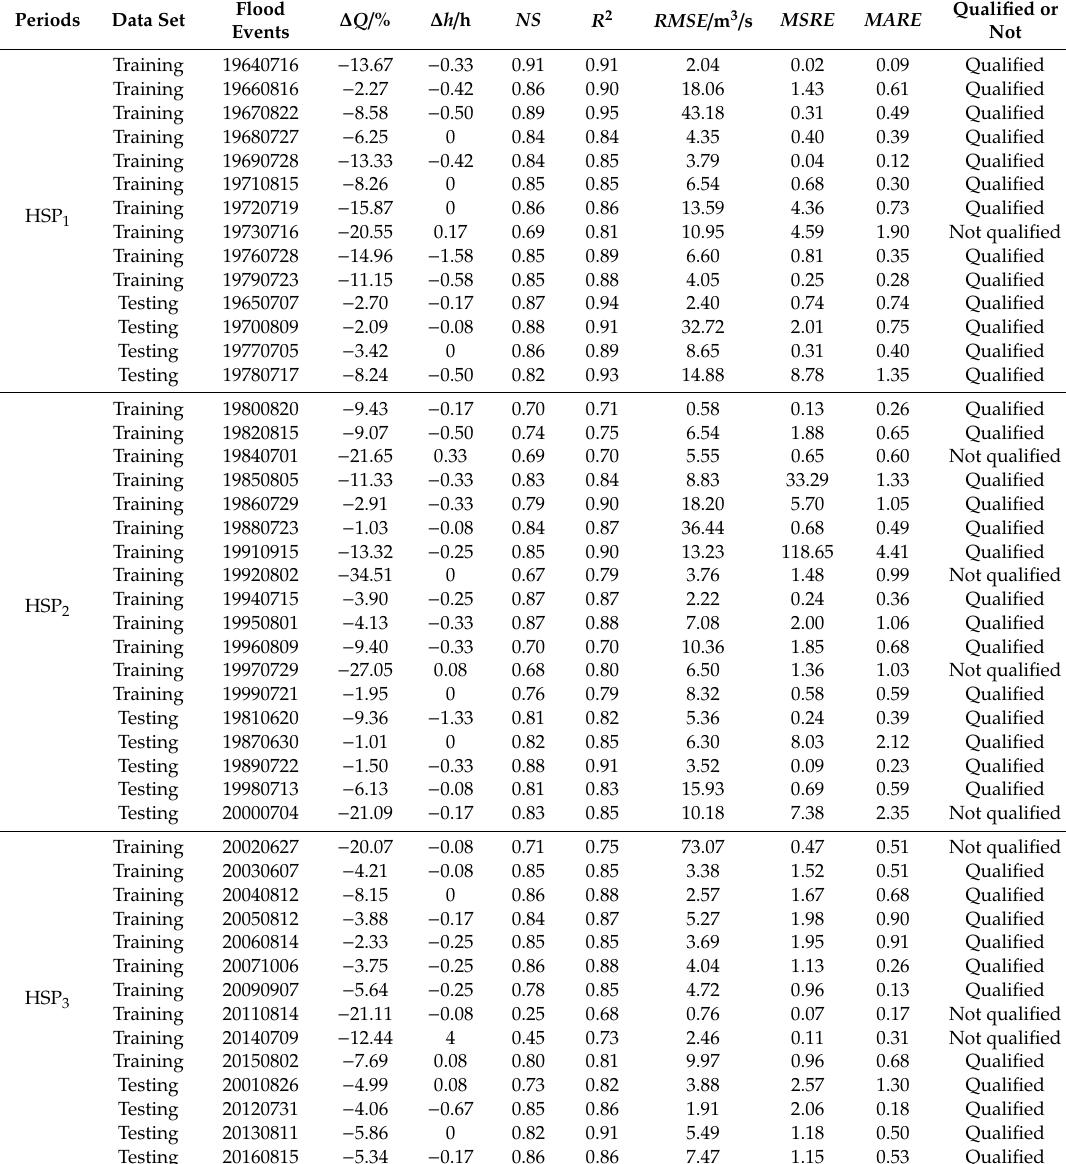
Table 4. Evaluation of flood simulation results by KNN-FWA-ELM